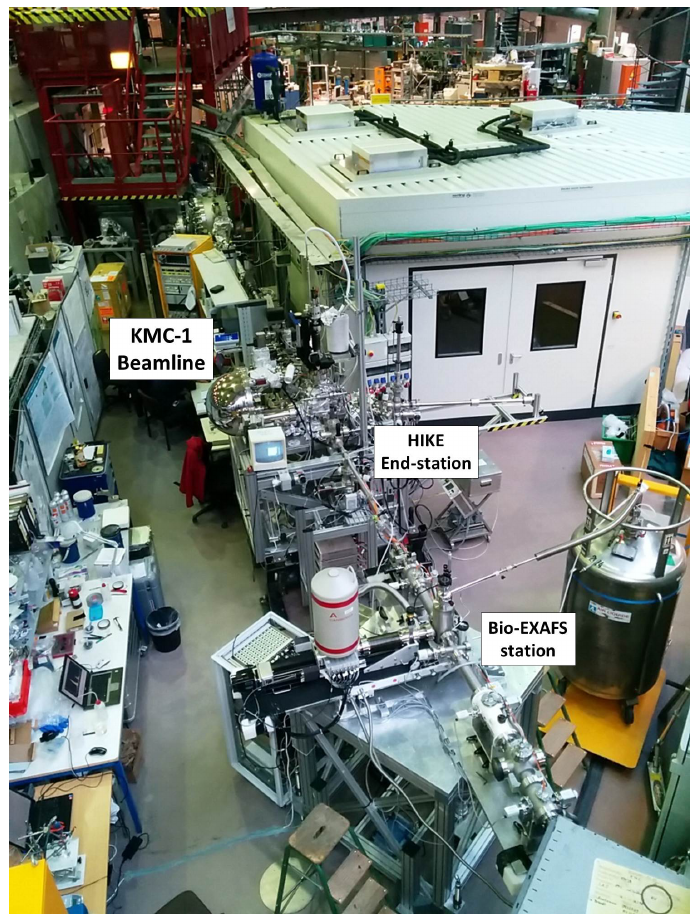
Figure 1: Top-view of beamline